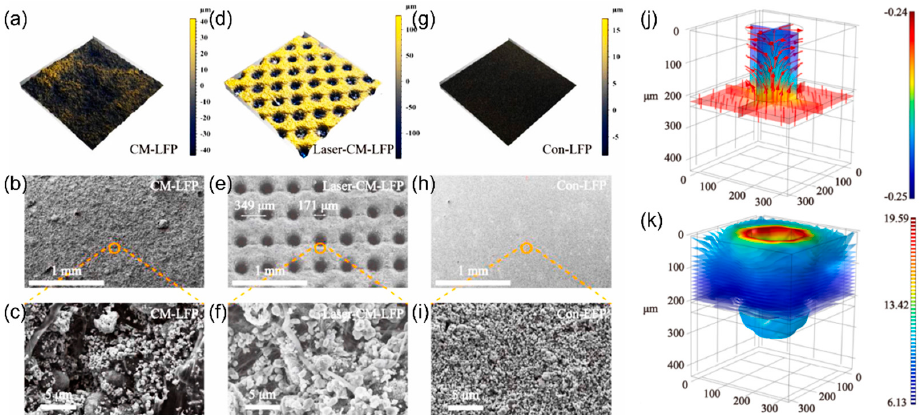
Figure 12. 3D reconstruction images and SEM images of ( a – c ) CM-LFP (LFP cathode with CNFs and MWCNTs), ( d – f ) Laser-CM-LFP (laser-drilled CM-LFP cathode), and ( g – i ) Con-LFP (conventional LFP cathode). ( j ) Li-ion flux distribution, and ( k ) current distribution with laser-drilled holes in the electrode. Reproduced with permission from ref. [156]. Copyright 2021, Elsevier.